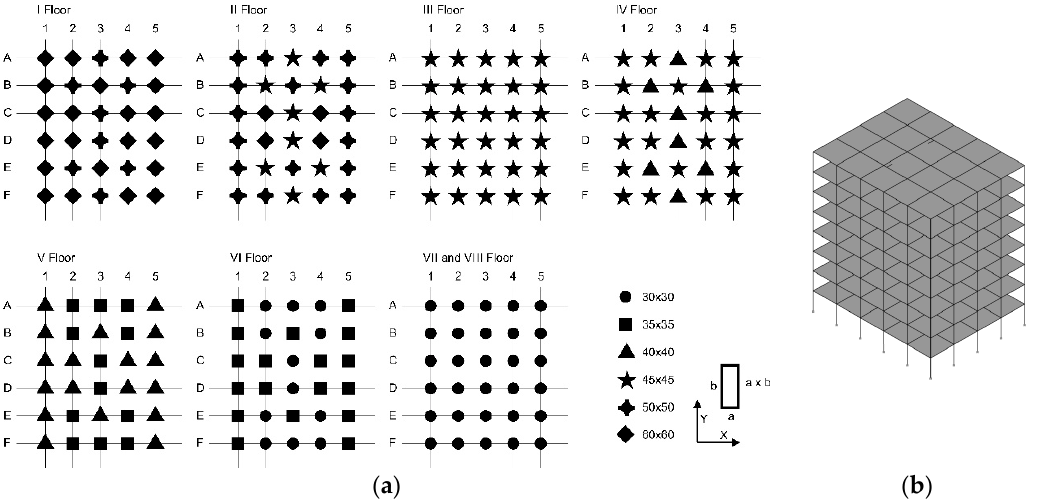
Figure 11. Eight storey building benchmark (Type 2): ( a ) the column cross section plan, and ( b ) the FEM model.